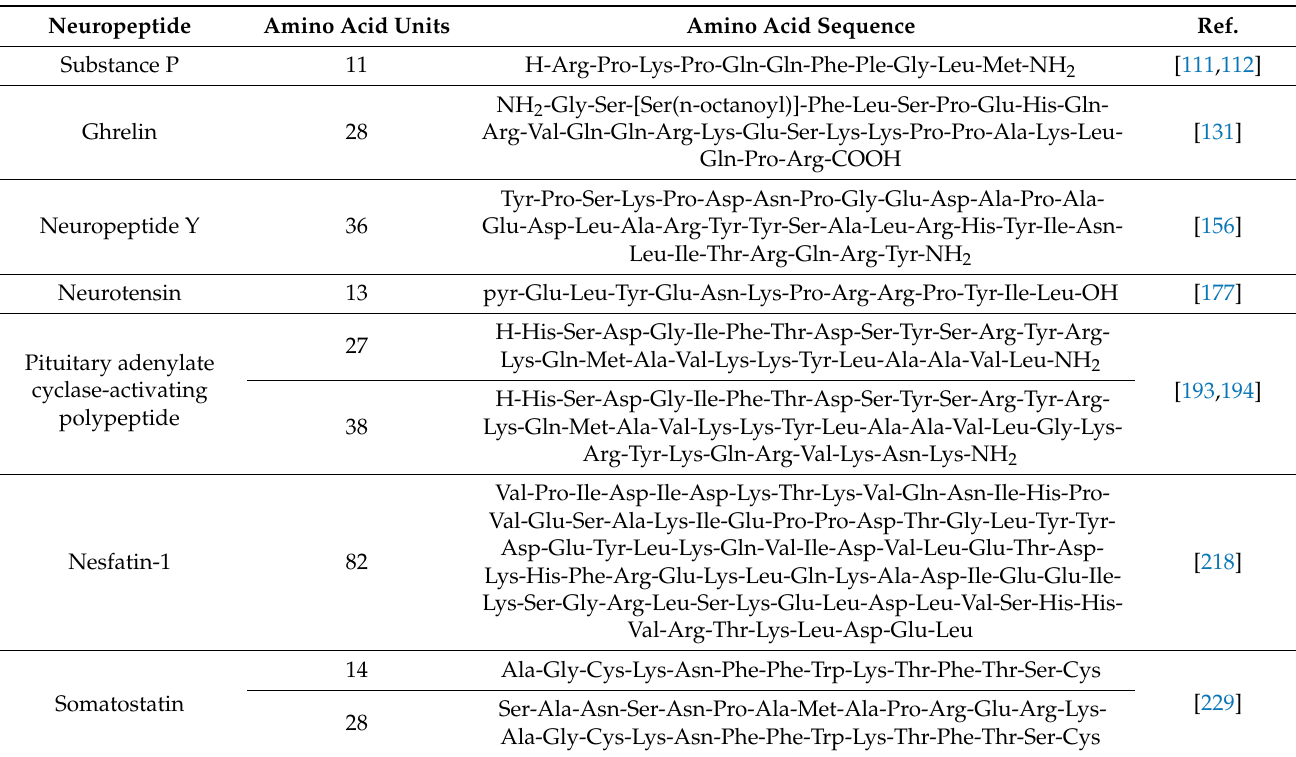
Table 1. The amino acid units and amino acid sequence of fundamental neuropeptides that contribute to significant neuroprotection in Parkinson’s